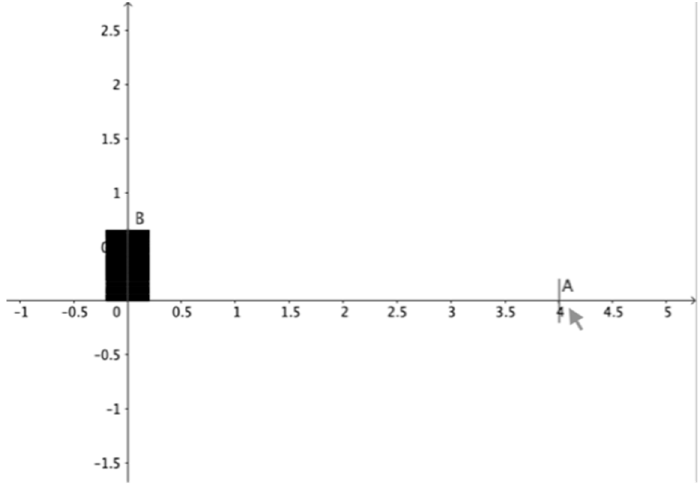
Figure 4. By activating the trace mark on B, while dragging A from 1 to 4 , it is possible to visualize f ([ 1,4 ]) on the screen.